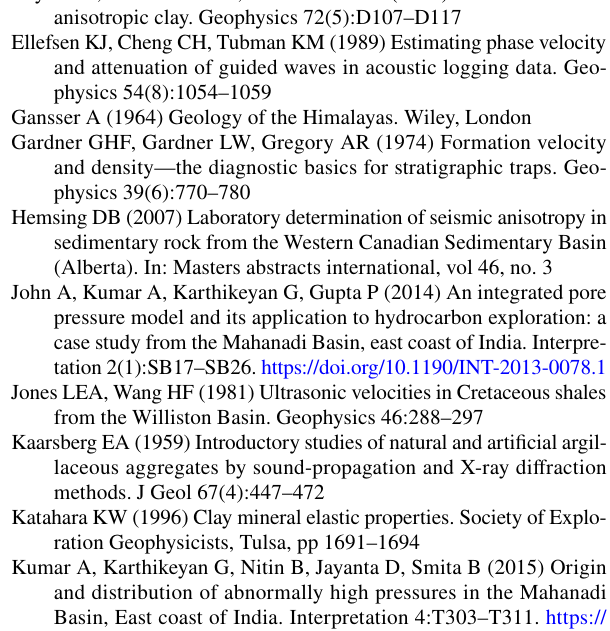
δ 1 and 2 ) derived